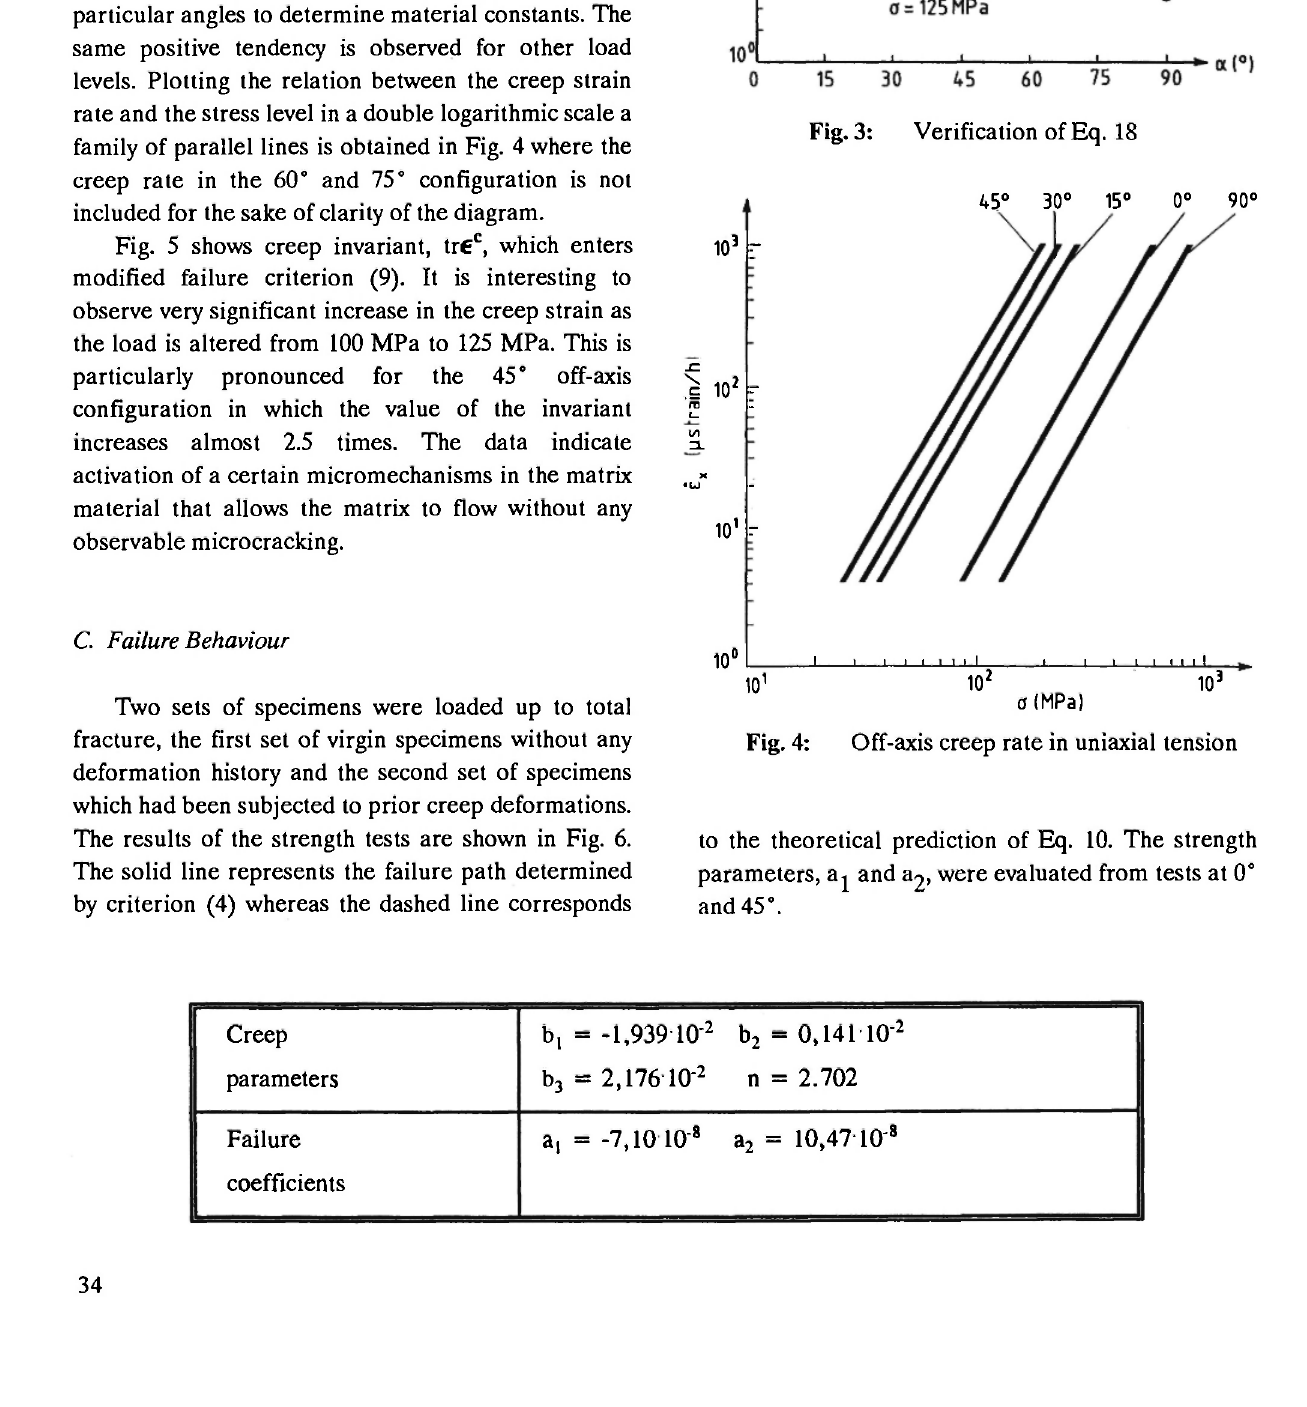
Fig. 3: Verification of Eq. 18